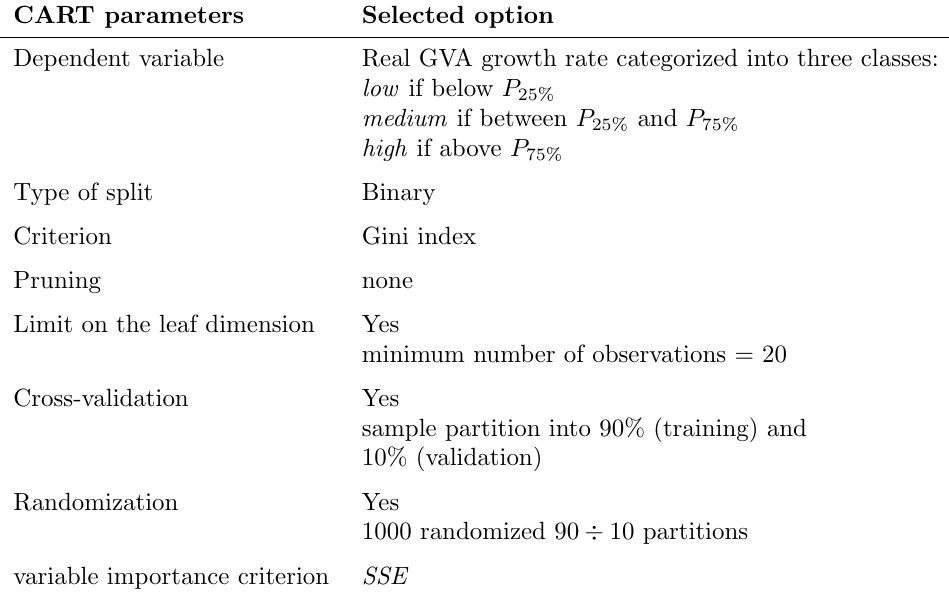
Table 1: Parameters used for the CART